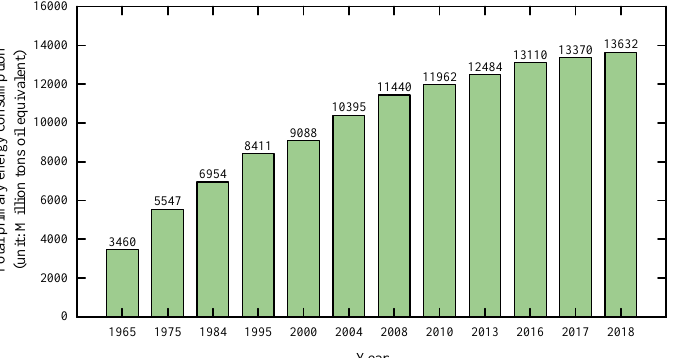
Figure 2. The global energy consumption trends in the past years (1965–2018) [15].